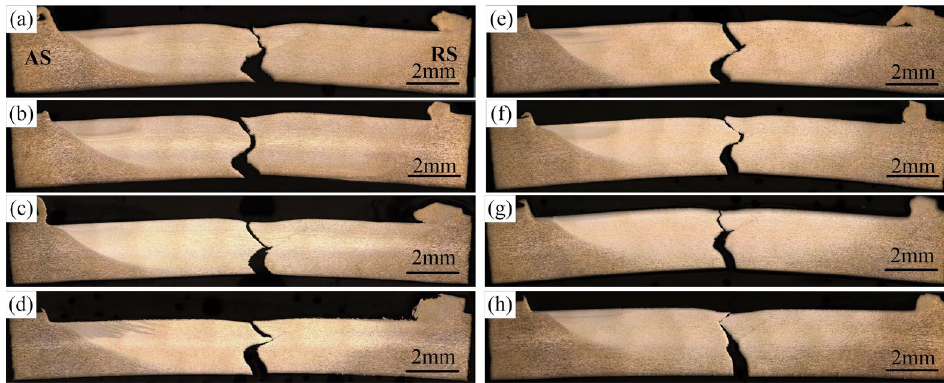
Figure 14. Microhardness distribution on the transverse cross-section of the joint: ( a ) variation with rotation speeds, v = 30 mm/min; ( b ) variation with welding speeds, ω = 900 rpm; ( d = 12 mm).